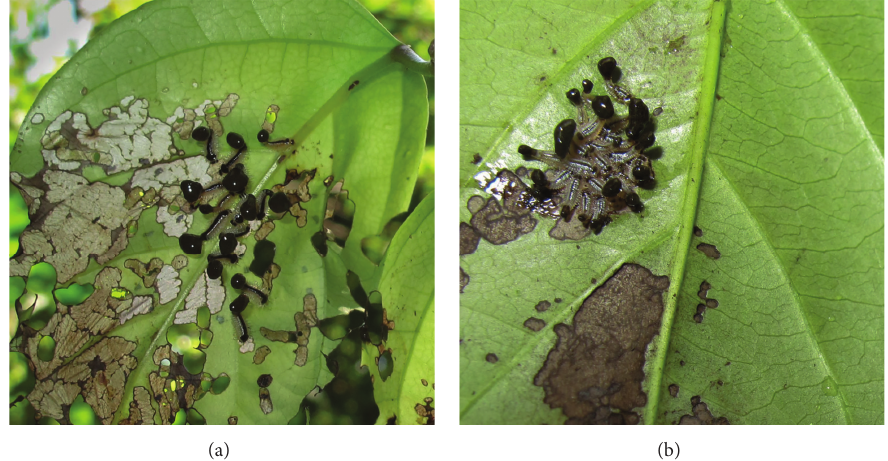
Figure 4: Coptocycla dolosa larvae, Potrerillos del Guend`a, Dept. Santa Cruz, Bolivia. (a) when active, feeding, or moving; (b) at rest. © D.